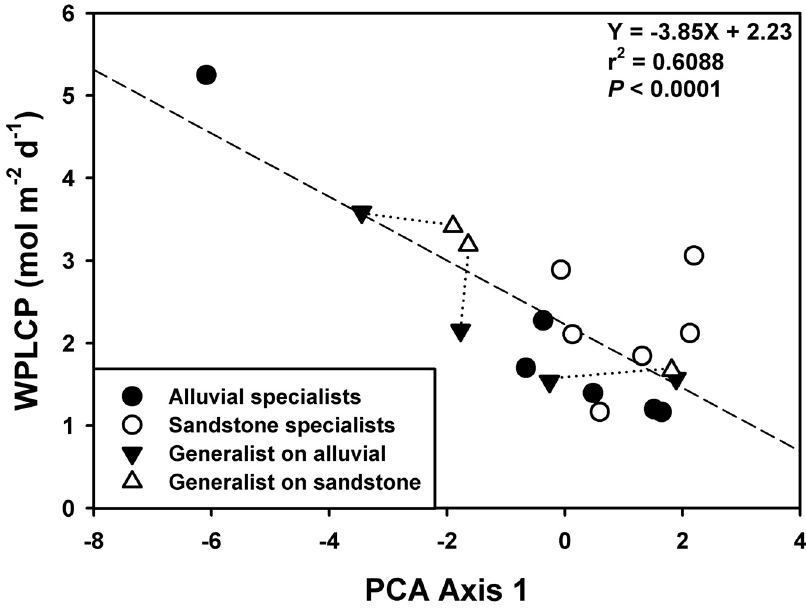
Figure 2. The relationship between the LES and shade tolerance quantified as the whole-plant light compensation point. The LES corresponds with species loadings on PCA axis 1. For a description of the axis see Figure 1 and Table 1. Whole-plant light compensation point values (WPLCP) are from Baltzer and Thomas [19]. Generalist species are represented by two data points each: one from the population on the alluvial soils (black triangles) and one from the sandstone soils (white triangles) and connected by a dashed line to demonstrate shifts in trait values between populations. WPLCP could not be estimated for the sandstone population of K. laurina thus only the alluvial population is represented in this figure.